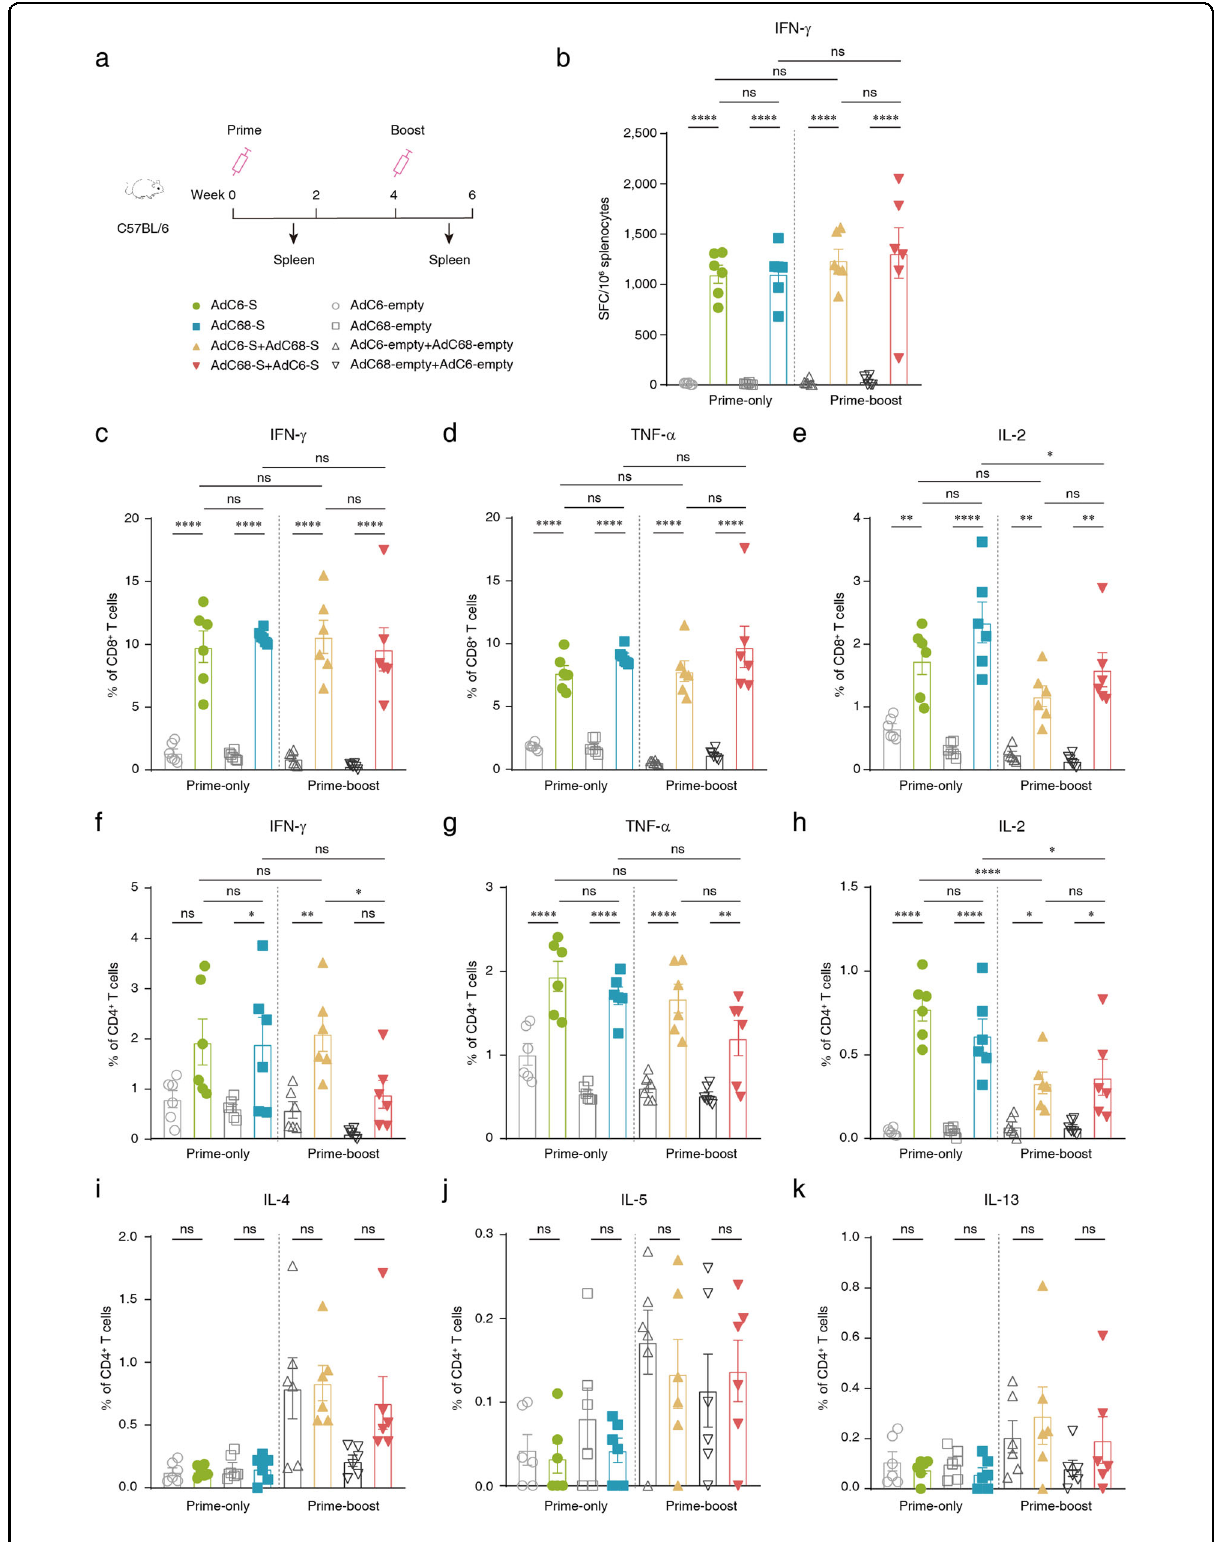
Fig. 2 (See legend on next